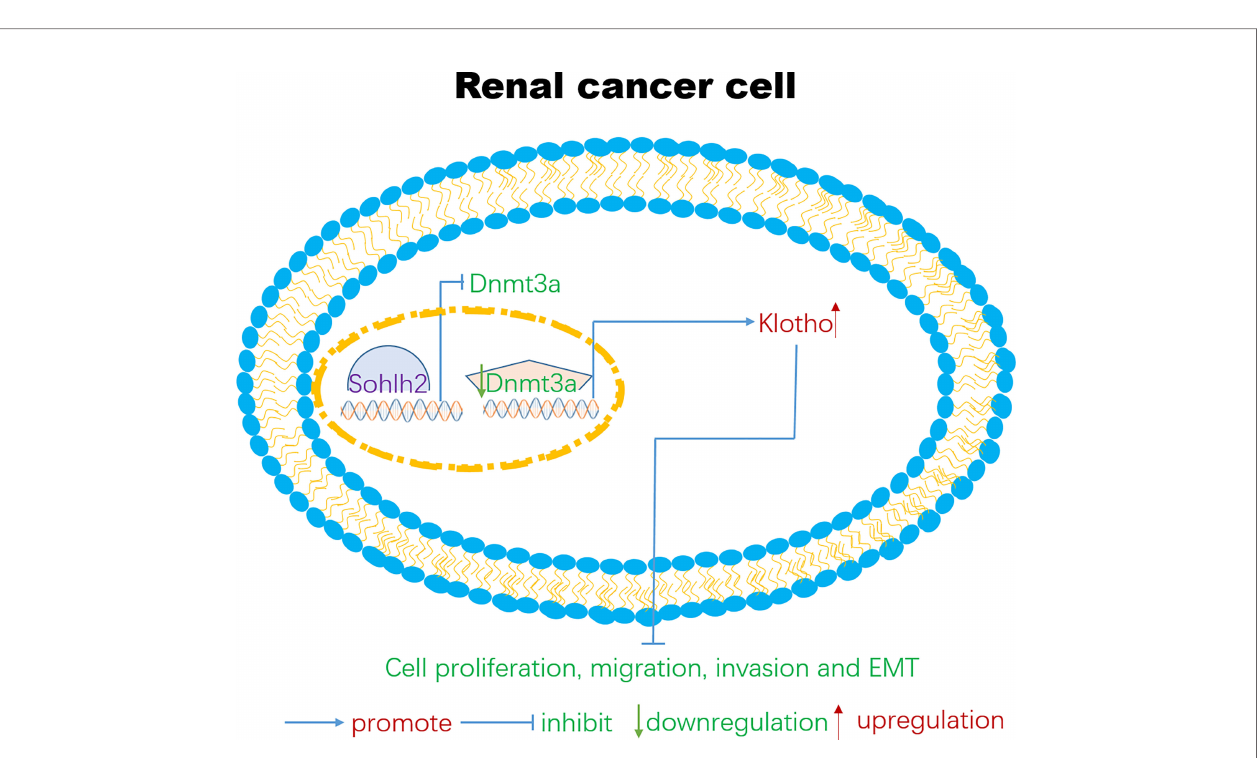
FIGURE 7 | A possible signaling pathway for Sohlh2 to function as a tumor suppressor in renal cancer cells. At present, targeted therapeutic molecules have been developed for certain signaling pathways such as PT 2385 and PT 2399. PT 2385 and PT 2399 are small molecule inhibitors of HIF-2, which can selectively interfere with the heterodimerization of HIF-2 a and HIF-1 b . Clinical data show that these small molecules inhibitors could effectively block the proliferation and tumor angiogenesis of RCC cells (49). The signaling pathways are very perplexing in the tumor microenvironment; lncRNA, miRNA, and many other signaling pathways are also involved in the occurrence and development of RCC cells (50 – 53). We hope that our fi ndings could provide new therapeutic targets and new view sights for the therapy of RCC. RCC, renal cell carcinoma.